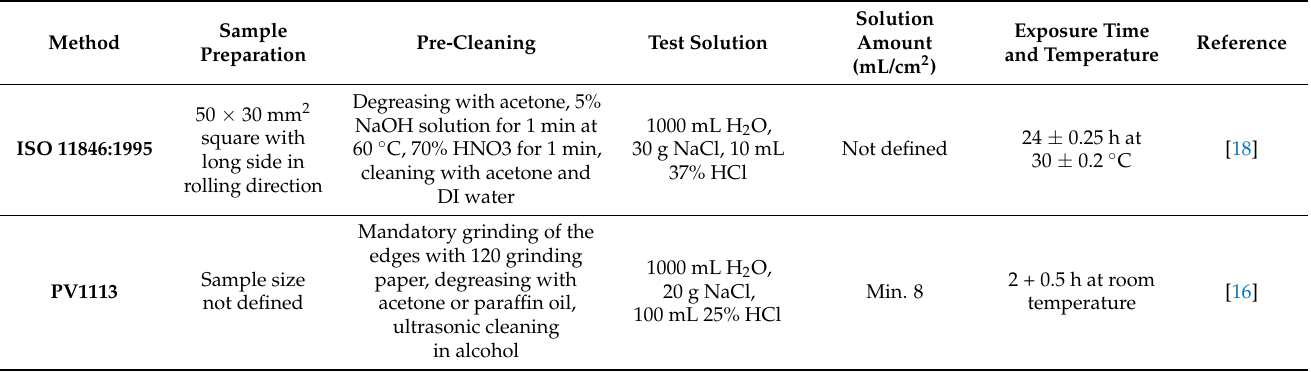
Table 2. ISO 11846:1995 and PV1113 testing method